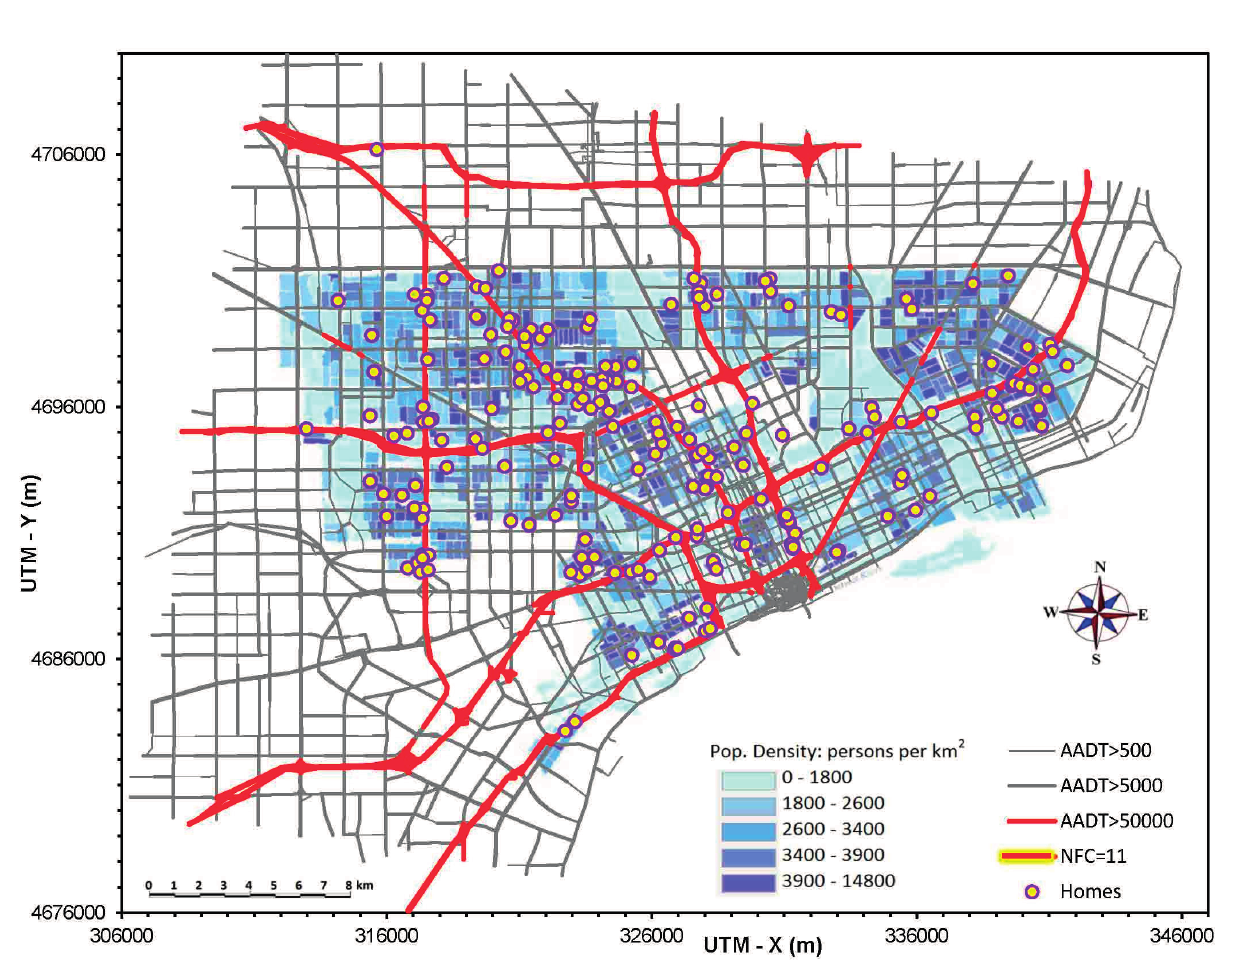
Figure 1. Map of modeled road network in study area, and locations of 218 homes of participants in NEXUS. Shaded area defines city of Detroit and population by Census Block group. Axis scales are Universal Traverse Mercator coordinates (m). AADT is annual average daily traffic (vehicles/day). Highlighted roads are National Functional Class 11, called high diesel/high traffic roads in NEXUS. Windsor, Canada (not shown), is immediately to the